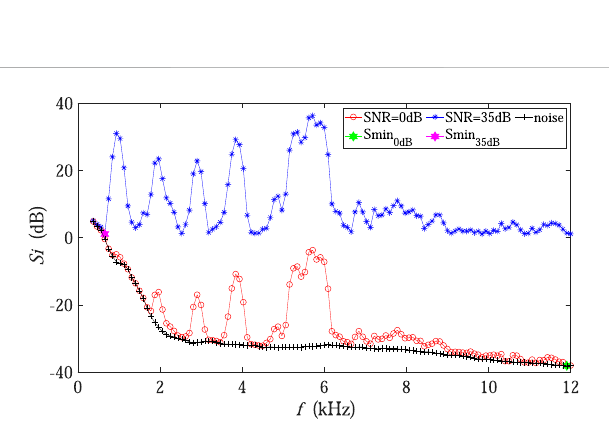
FIGURE 6 In fl uencemechanismanalysisconcerningBIOinExperiment2.The redandbluepointsrepresentthesoundlevelofeachfrequencybandfor the experimental recording under 0 dB and 35 dB SNR conditions, respectively. The green and purple dots mark the minimum values of the sound level in 0 dB and 35 dB SNR conditions, respectively. The black points denote the sound level of the background noise spectrum, which was fi xed in Experiment